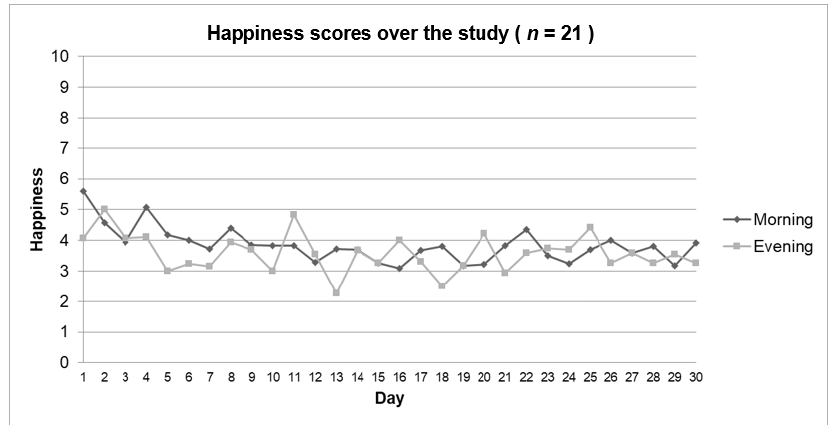
Figure A1. Graphical Representation of Happiness Over the Study.